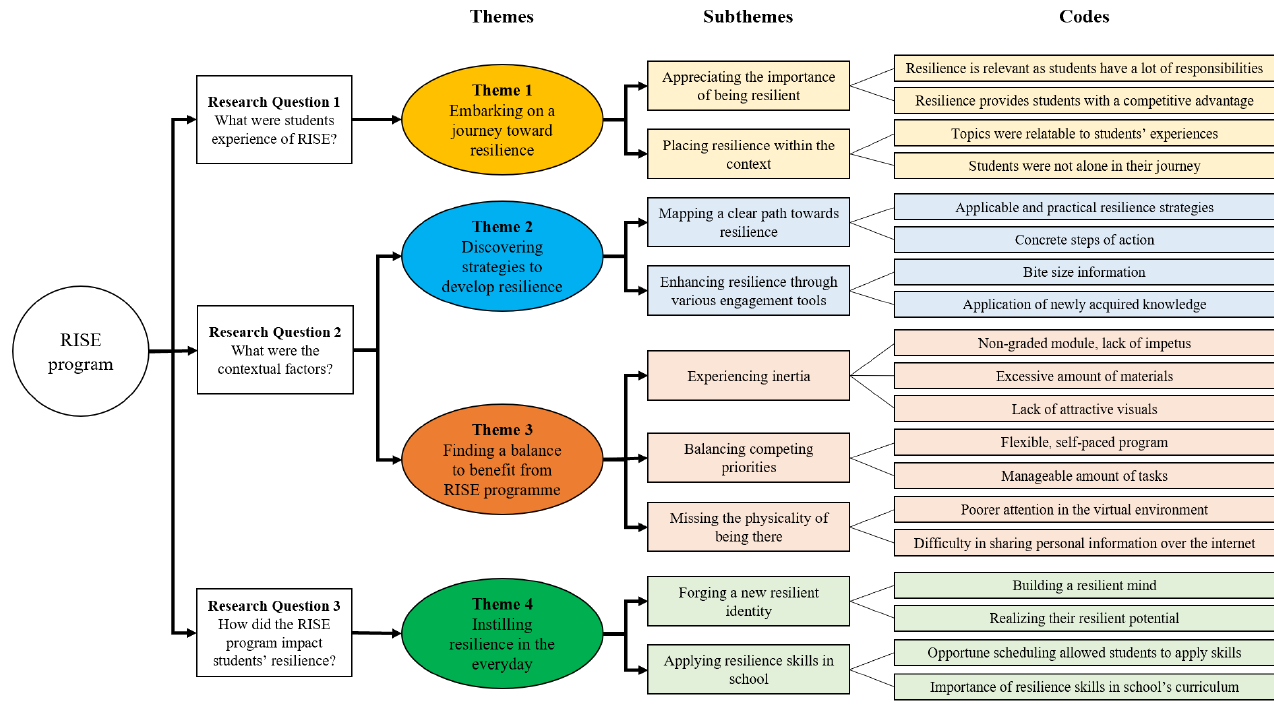
Figure 2. Coding